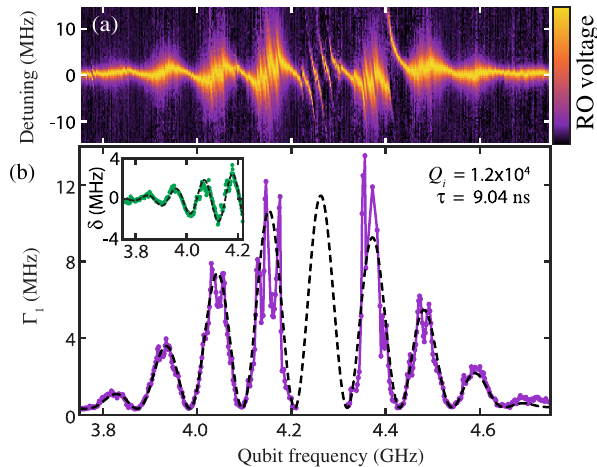
FIG. 3. Interaction with propagating phonons. (a) Tuning the qubit across the ∼ 1 -GHz IDT bandwidth probes its interaction with the continuum of propagating phonons outside the mirror band. Subtracting the expected flux tuning without acoustic interactions makes clear an oscillatory feature in both linewidth and frequency as seen in the measured readout (RO) voltage. Zigzag features bordering the central coherent avoided crossings are well described as resonant interactions with lossy acoustic modes. A strongly coupled system is present at 4.41 GHz that is not a SAW-cavity mode. (b) The decay rate Γ 1 is found by measuring the qubit T 1 decay time. The measured energy loss rate varies by more than a factor of 25 within a 55-MHz span. A model closely fits the measurement except in the regions with the largest Γ 1 , where increased uncertainty from the short decay times compounds with effects from the semireflective mirrors that are not included in the model. The measured frequency-depen- dent Lamb shift δ agrees well with the calculations from the IDT model